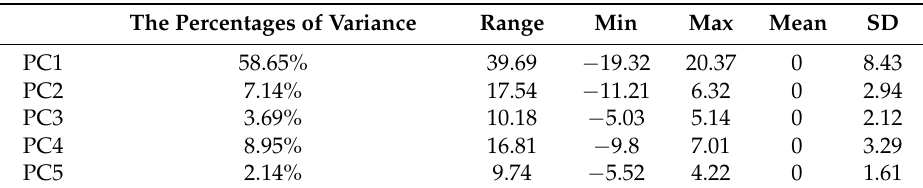
Figure 3. Moran’s I index of soil organic carbon density (SOCD) and principal components (PCs) in different distances. Table 2. The basic statistics of the first five principal components (PCs) of the spectral information which were extracted from the principal least squares regression model.